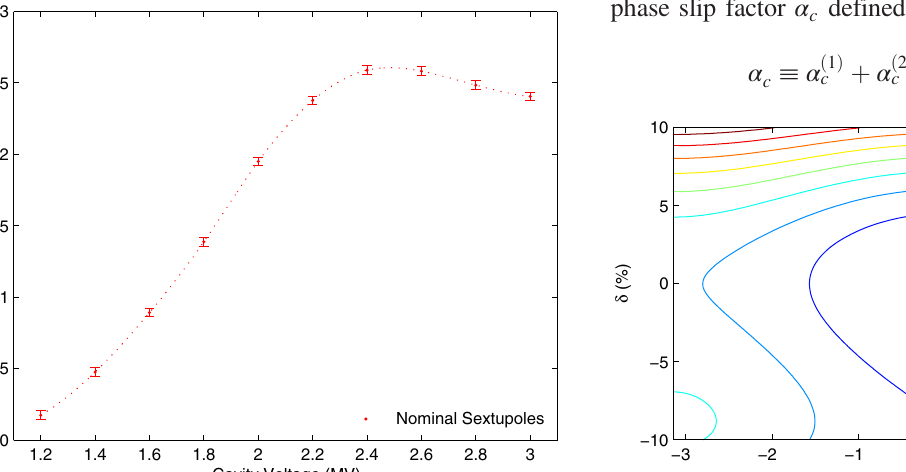
FIG. 6. Longitudinal phase space for Diamond with V 4